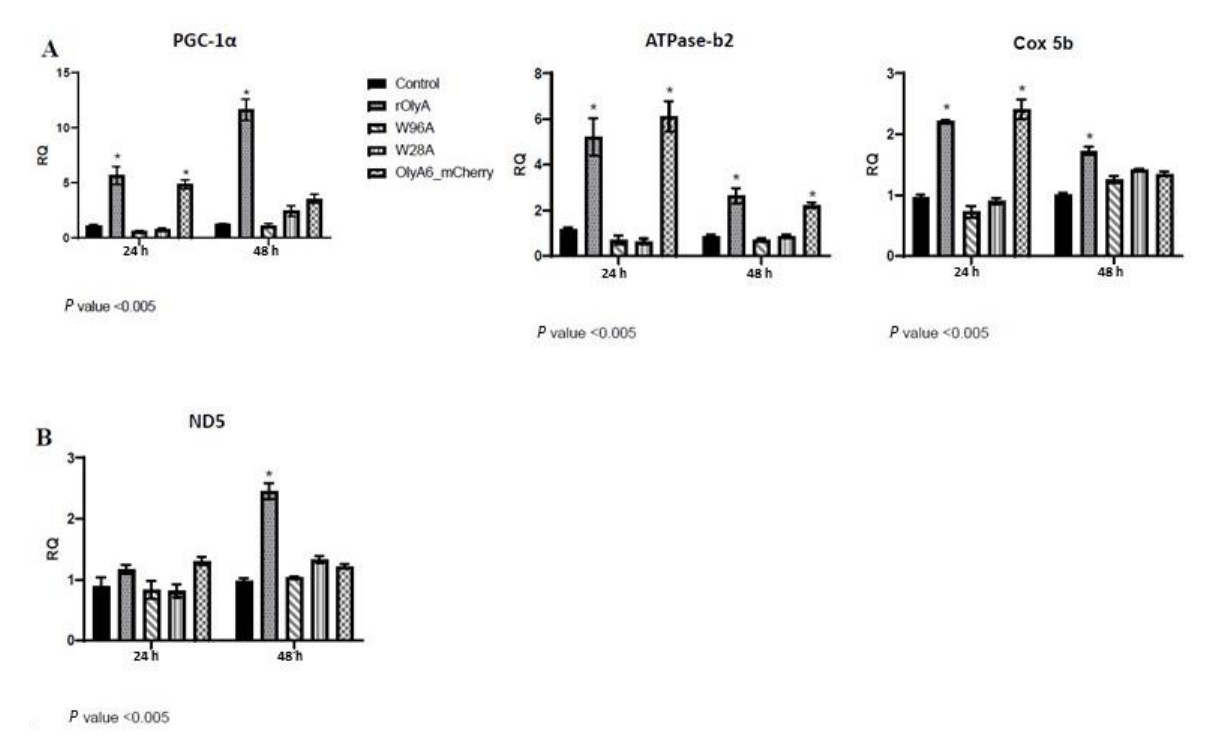
Figure 5. Screening for expression of mitochondrial markers using real-time RT-PCR. Preadipocyte mRNA was measured by quantitative RT-PCR as described in the Materials and Methods section. Gene expression in HIB-1B cells 24 h and 48 h after addition of proteins to growth medium: rOlyA, W96A, W28A (10 µ g mL − 1 ); OlyA6-mCherry (30 µ g mL − 1 ); and control (mock). Graph representation: y-axis—RQ (relative quantification), bars represent treatments with proteins. Each graph represents HIB-1B cell treatments for 24 h and 48 h. ( A ) Nuclear-encoded mitochondrial marker and biogenesis regulator genes, associated with energy generation and expenditure from lipid and glucose source. ( B ) Mitochondrion-encoded marker gene ND5 . All results were normalized to RPL 41 gene expression. All data are expressed as mean ± s.e.m., n = 4–6; * p <